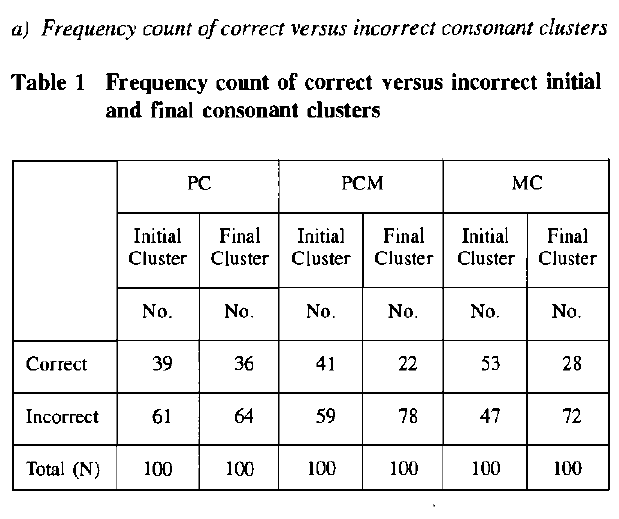
Table 2 Breakdown of correct initial and final